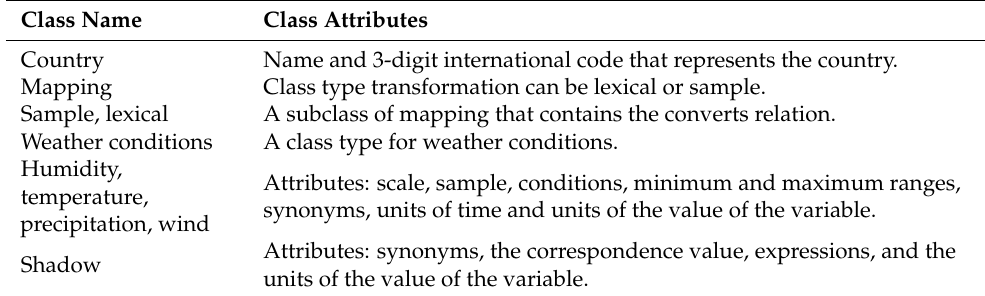
Table 5. Concept dictionary for the Country, Mapping, Sample, Lexical, Weather conditions, Humid- ity, Temperature, Shadow, Precipitation, and Wind